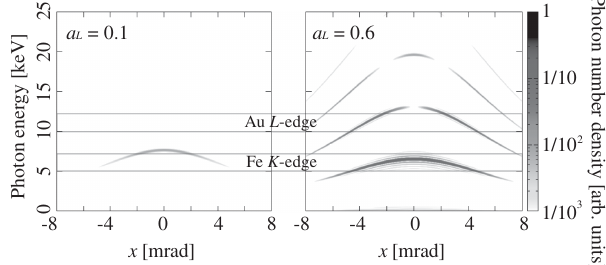
FIG. 5. Angular-frequency spectral distributions of the funda- mental, 2nd and 3rd harmonics, numerically calculated for ICS emission with a L ¼ 0 . 1 (left) and a L ¼ 0 . 6 (right), based on a Lienard-Wiechert field potential.